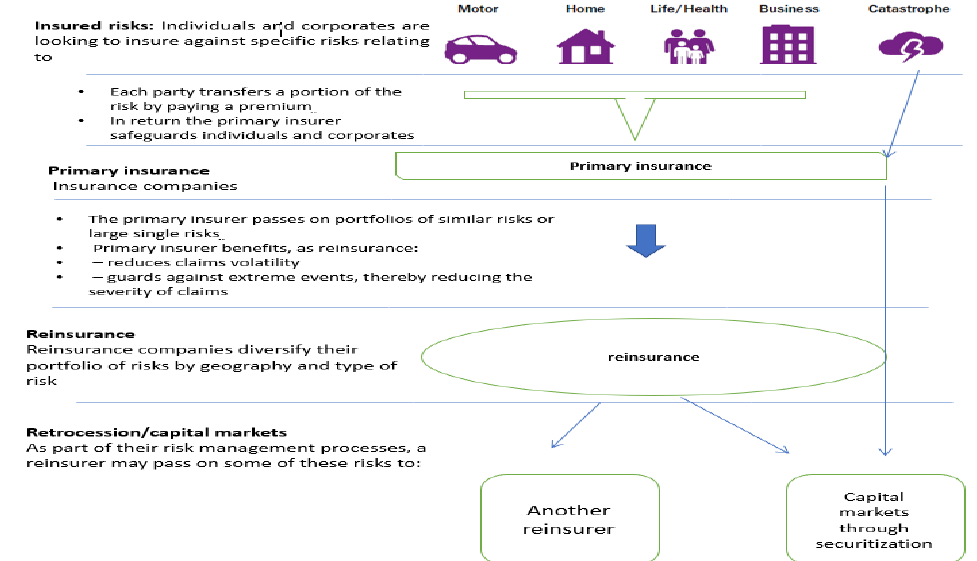
Figure 1 - How risks are transferred in insurance and